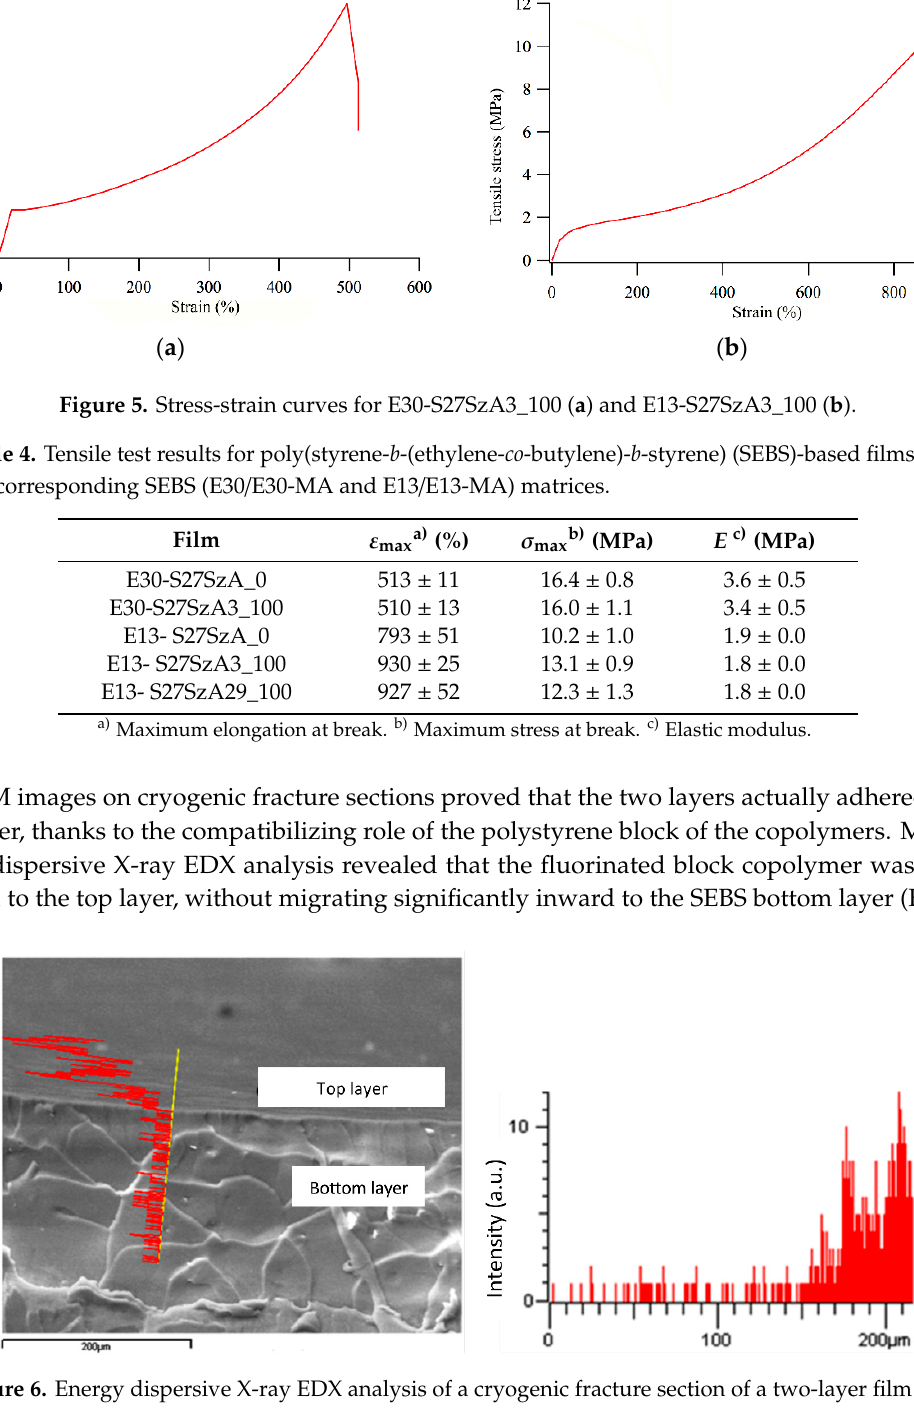
Figure 6. Energy dispersive X-ray EDX analysis of a cryogenic fracture section of a two-layer film line indicates fluorine (red line indicates fluorine concentration).